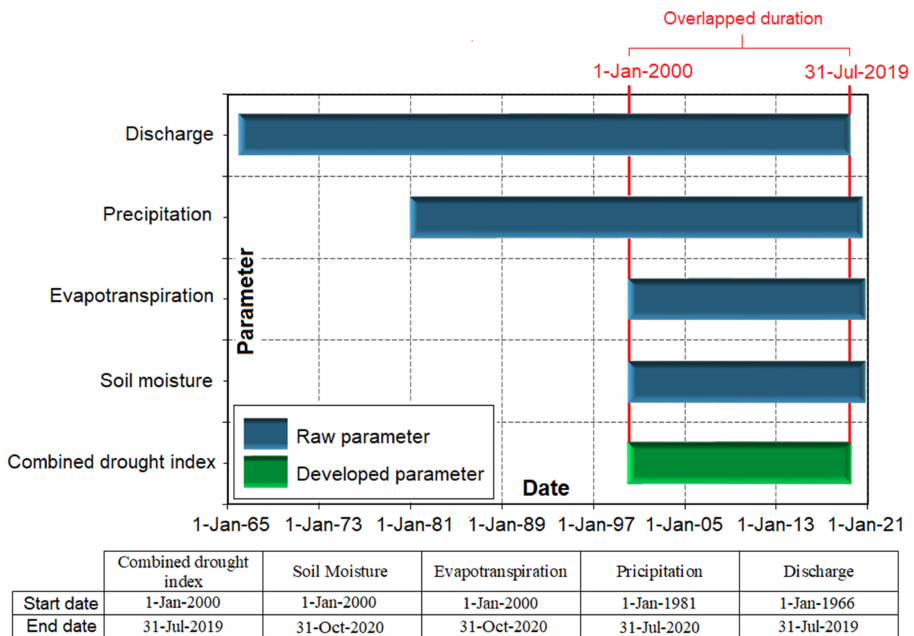
Figure 5. The temporal length of each parameter and the BN combined